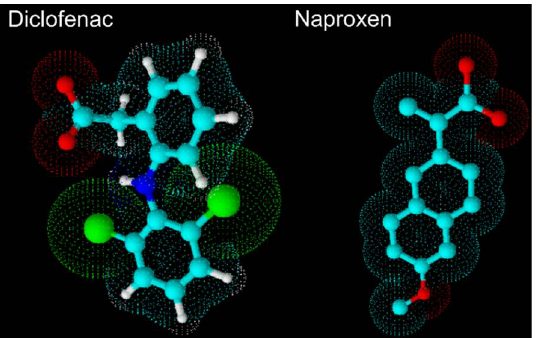
Figure 1. Three-dimensional structural formula of diclofenac and naproxen from ACD/ChemSketch 12.01.